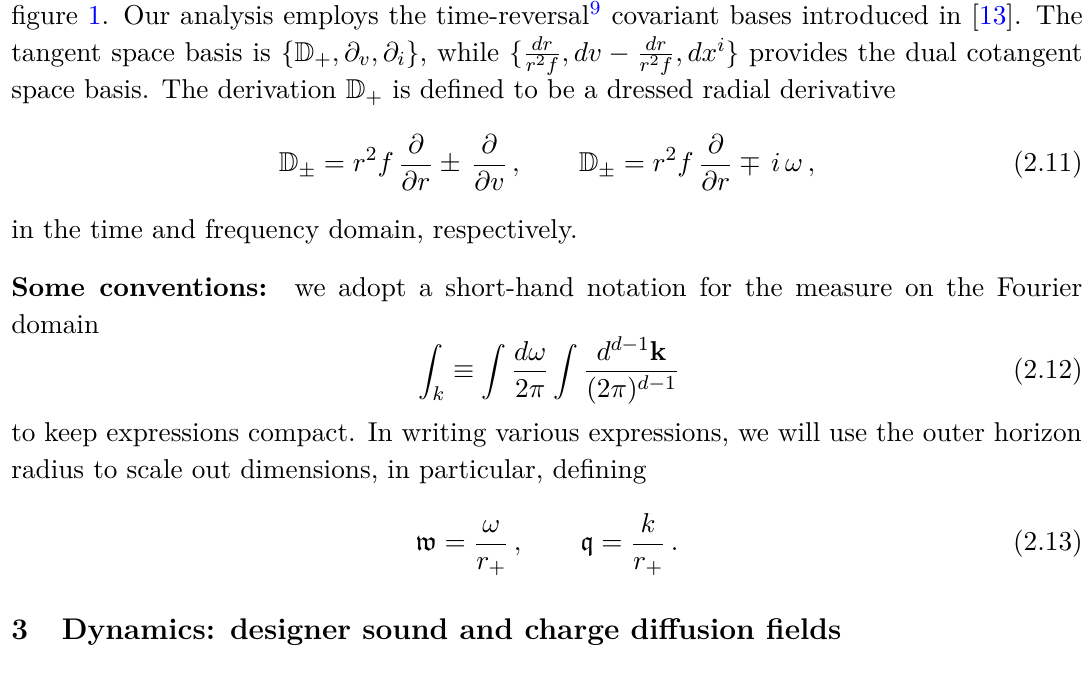
figure 1. Our analysis employs the time-reversal 9 covariant bases introduced in [13]. The tangent space basis is { D